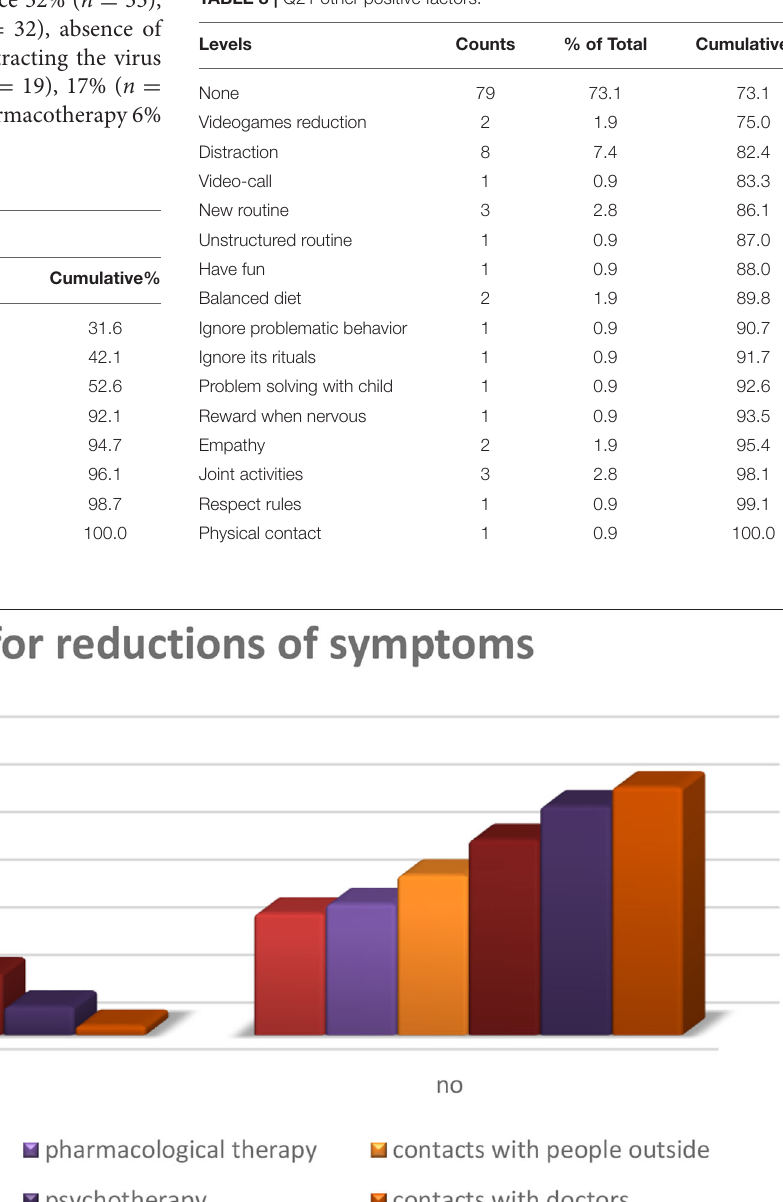
FIGURE 3 | Q.21. Which factors do you think favor reduction of symptoms at this moment?